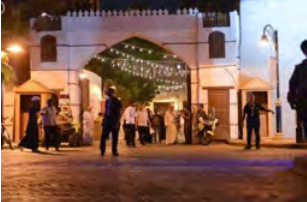
Figure 4. Shows the Huge Gates of the festivals that are open for people only